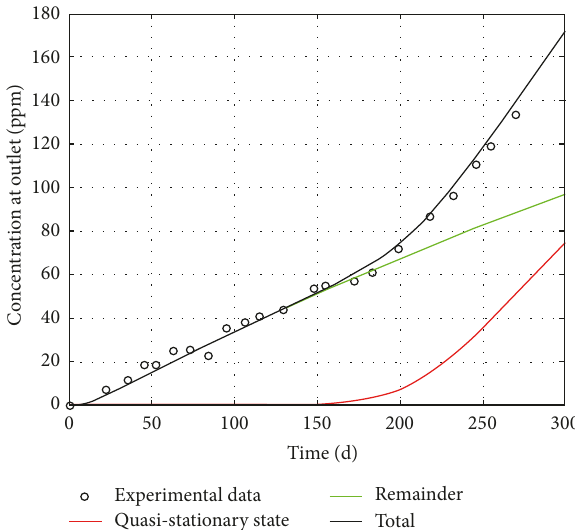
Figure 1: Evolution of the outlet concentration versus time in the C 2 H 6 diffusion experiment in Opalinus Clay. A clear breakthrough after a couple of days, leading to a quasi-stationary state is followed by an sudden unexplained increase after more than 150